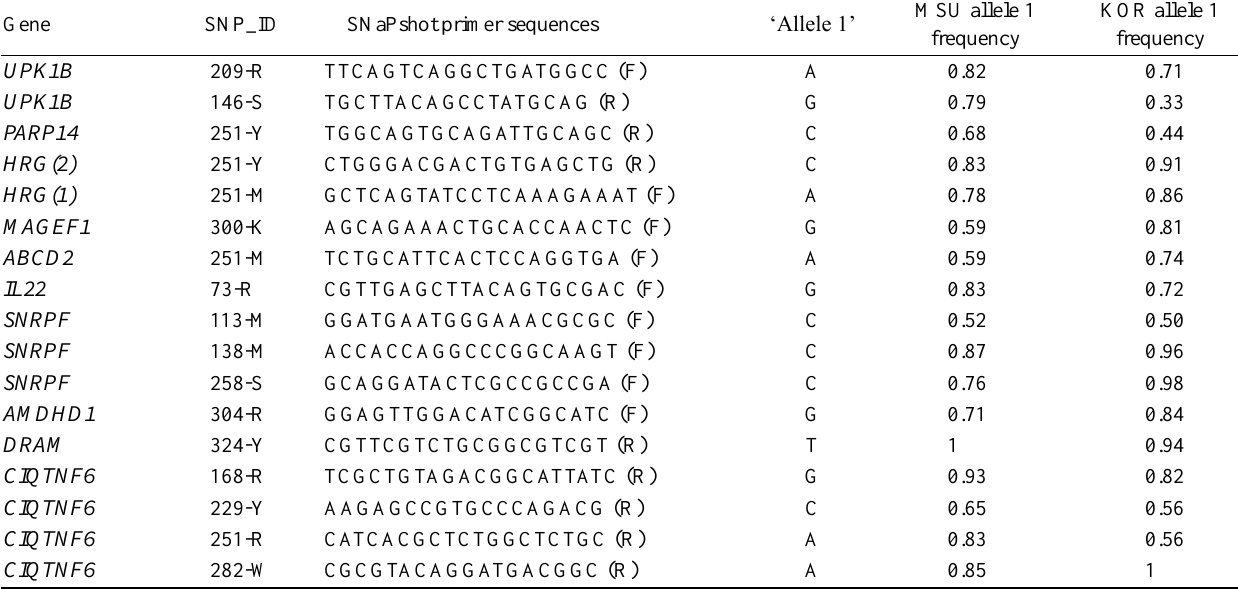
Table 3. List of probe information and allele frequencies of 17 polymorphisms on BTA1 and BTA5 genotyped in MCA/MSU and Korean cattle